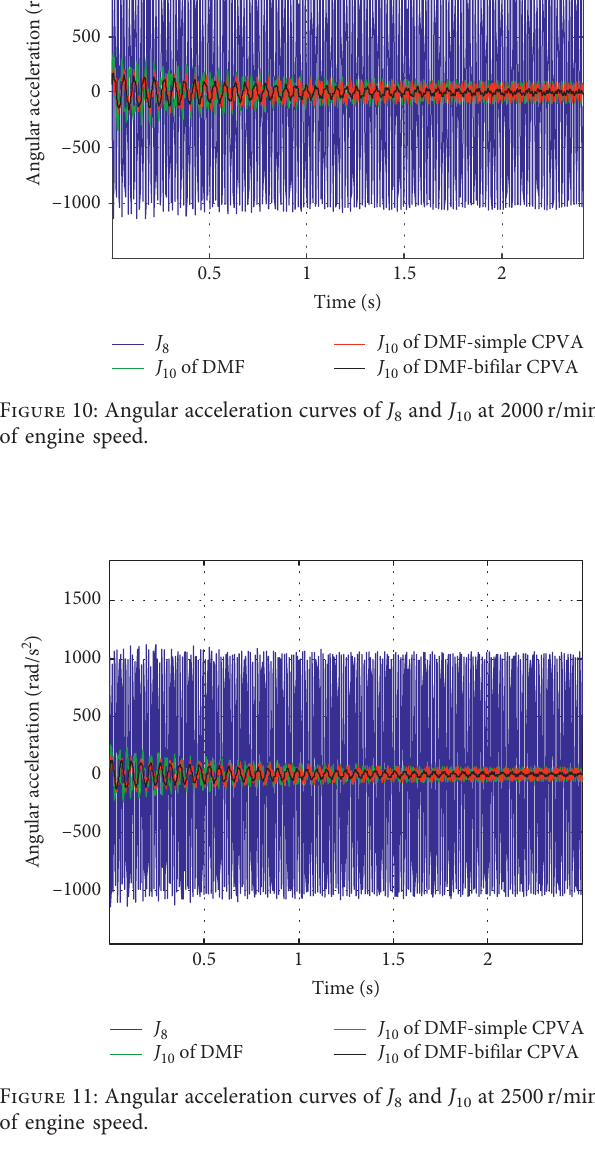
8 and J 10 at 1500r/min of